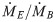
Variation as a function of cell numbers of various diagnostic parameters.The ratio M˙E/M˙B for different cases are M˙E/M˙B = 0 (black, Case A-1), 2 (blue, Case A-2), 4 (green, Case A-3), and 8 (red, Case A-4). Plots show (a) average number of fimbriae contacts (solid curves) and direct surface contacts (dashed curves) per bacteria, (b) porosity within the bacterial colony, and (c) minimum value of nutrient concentration cS,min/c0.